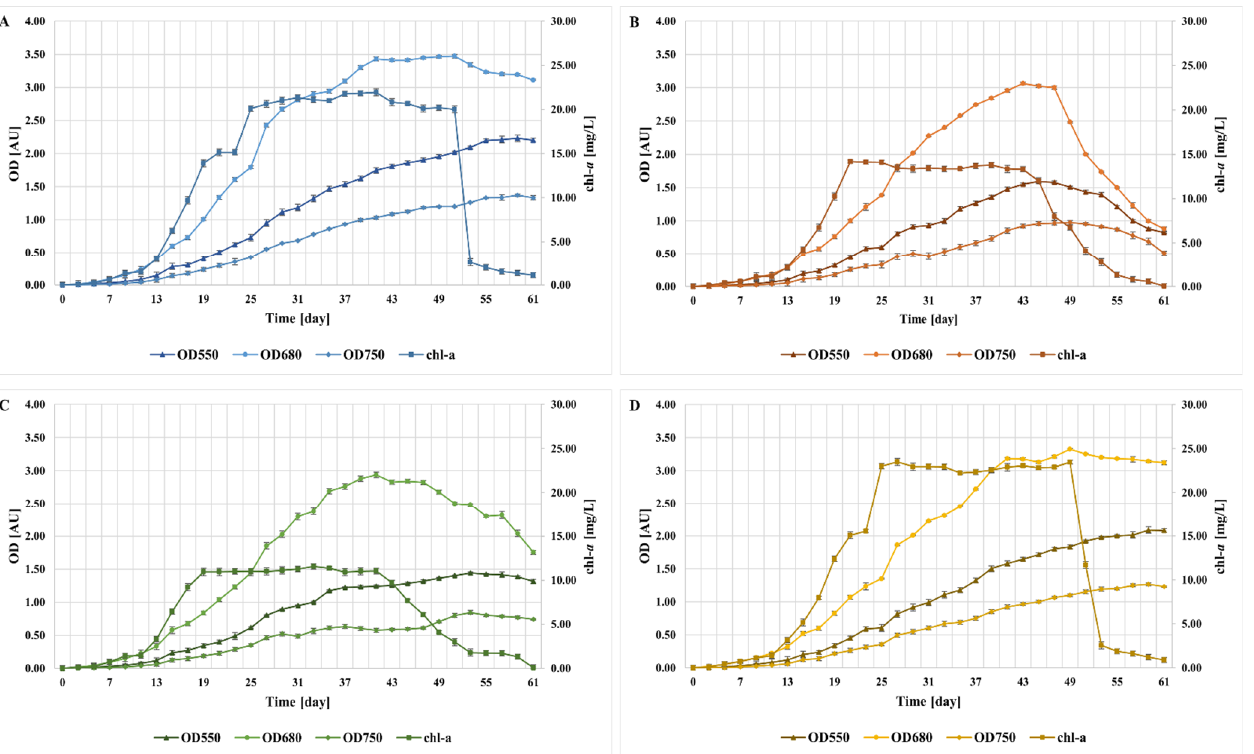
Figure 4. Growth curves of the mixed microalgae cultures ( A – D ). Each plot corresponds to the particular cultures designated as ( A – D ).